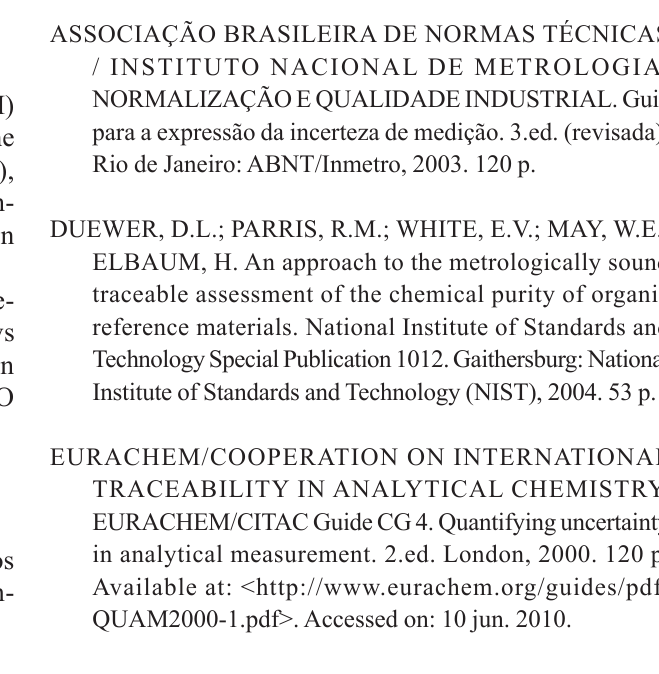
FIGURE 7 - DSC curve for captopril CRM in the 100-115 °C range (heating rate of 0.5 ºC/min) and inert atmosphere (He, 50 mL/min). Curves and values generated by the software TA Universal Analysis 2000 for calculation in purity